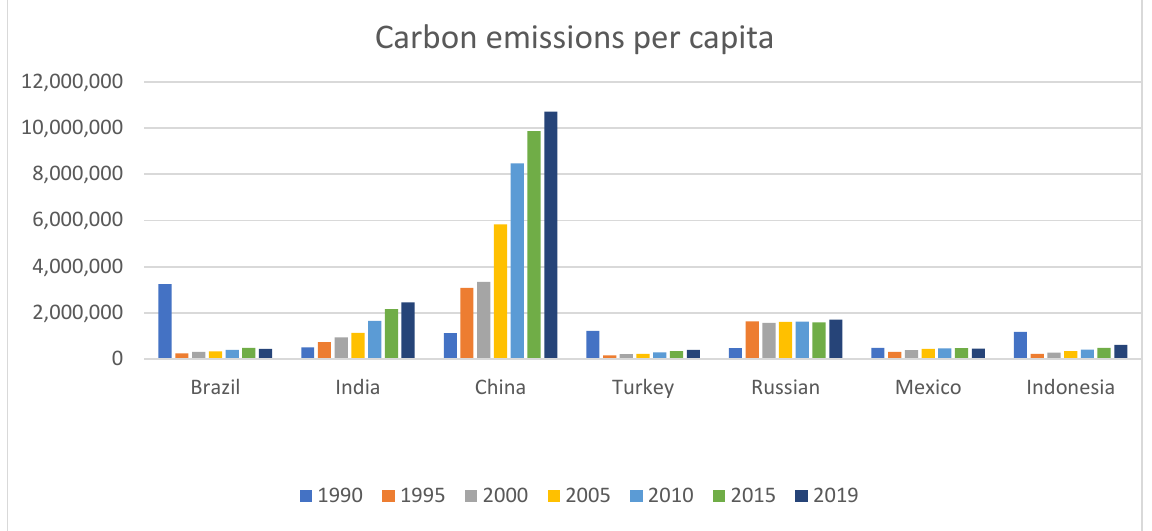
Figure 2. CO 2 emissions (metric tons per capita) in E-7 nations over the test period.